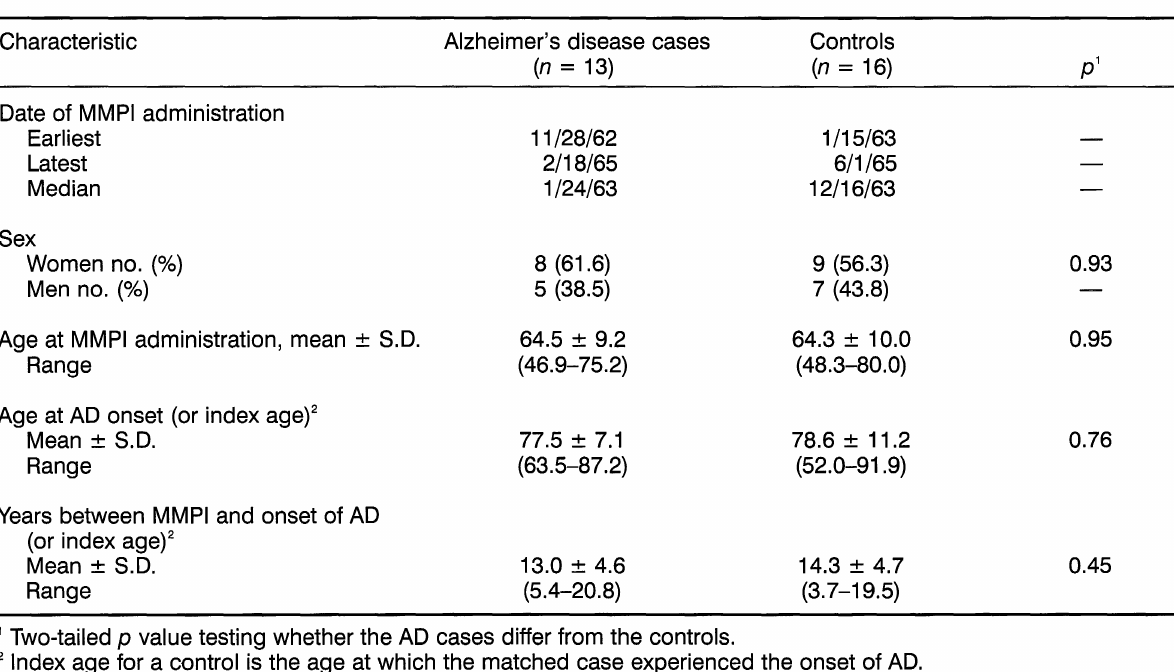
TABLE I. Characteristics of Alzheimer's disease cases and controls